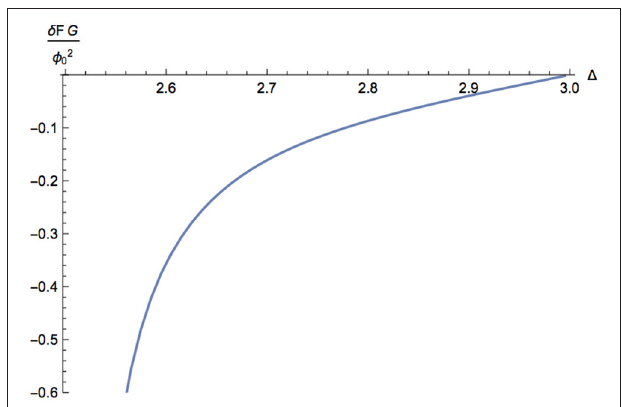
FIGURE 3 | The change in the renormalized free energy for 5 2 < 1 < 3.